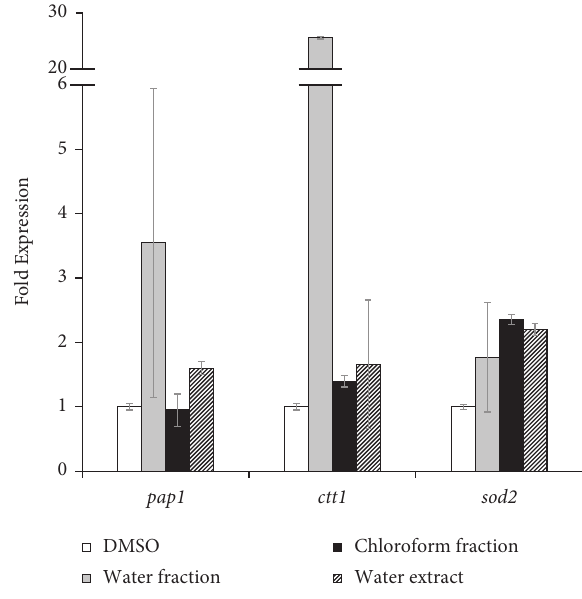
Figure 5: Antioxidant-related gene expression (pap1, ctt1, and sod2) of S. pombe cells treated with fraction and extract of S. nodiflora based on Reverse Transcriptase PCR analysis. Yeast cells were grown in YES liquid medium supplemented with water fraction, chloroform fraction, and water extract of S. nodiflora with each concentration of 1794, 3885, and 8000ppm, respectively. S. pombe culture treated with DMSO was used as a